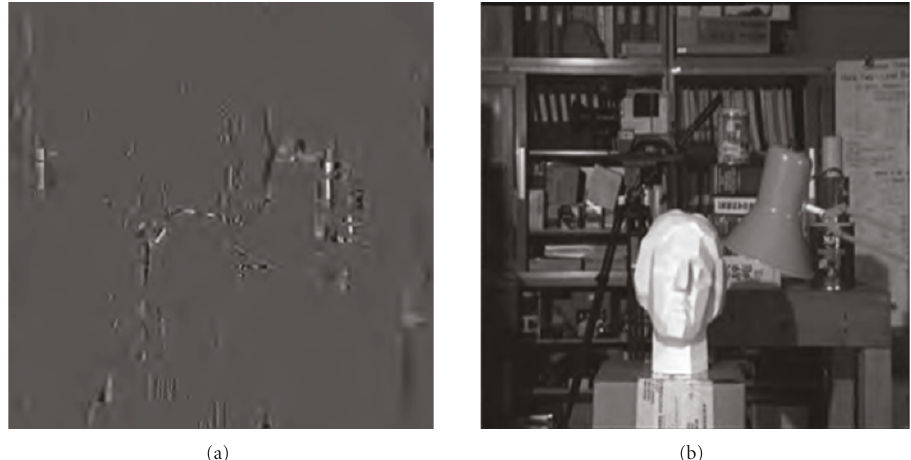
Figure 11: The reconstructed signal of H (a) and L (b) subbands. H and L subbands are encoded with bit rate 0.14bpp and 0.74bpp,